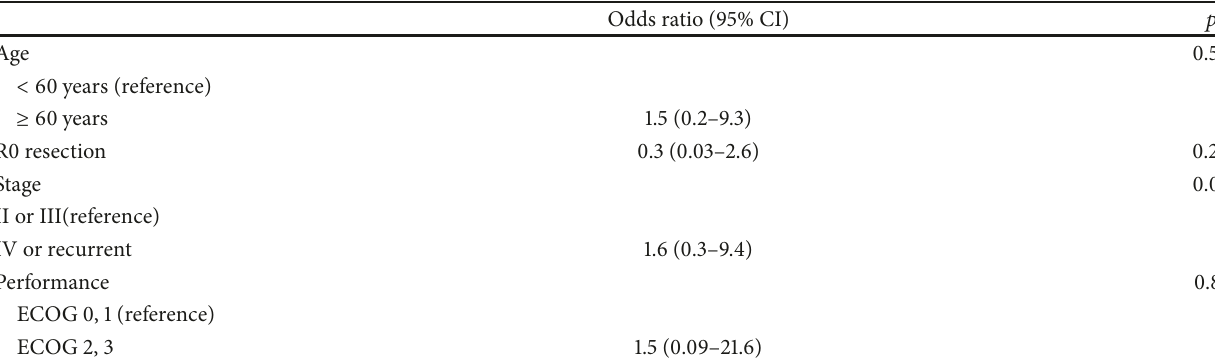
Table 3: Multivariate analysis of discordance between WFO and the